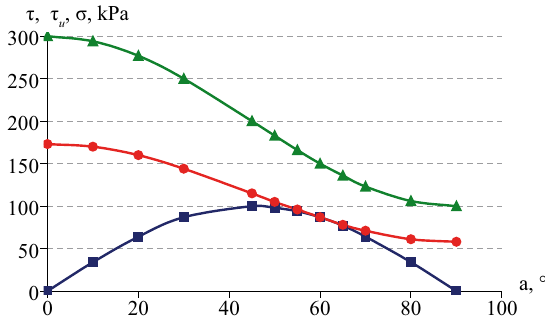
Fig. 3. Shear stresses τ and shear strengths τ u versus failure plane inclination α of clay